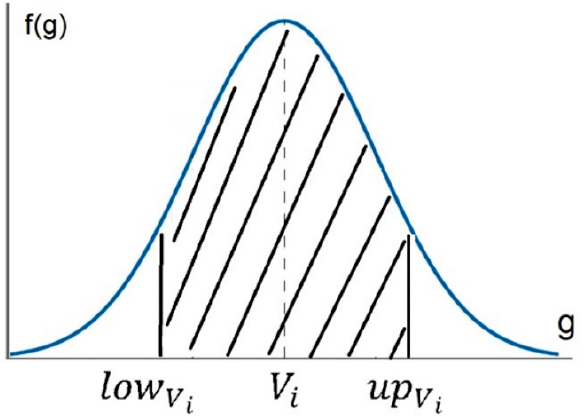
Figure 3. The histogram function.